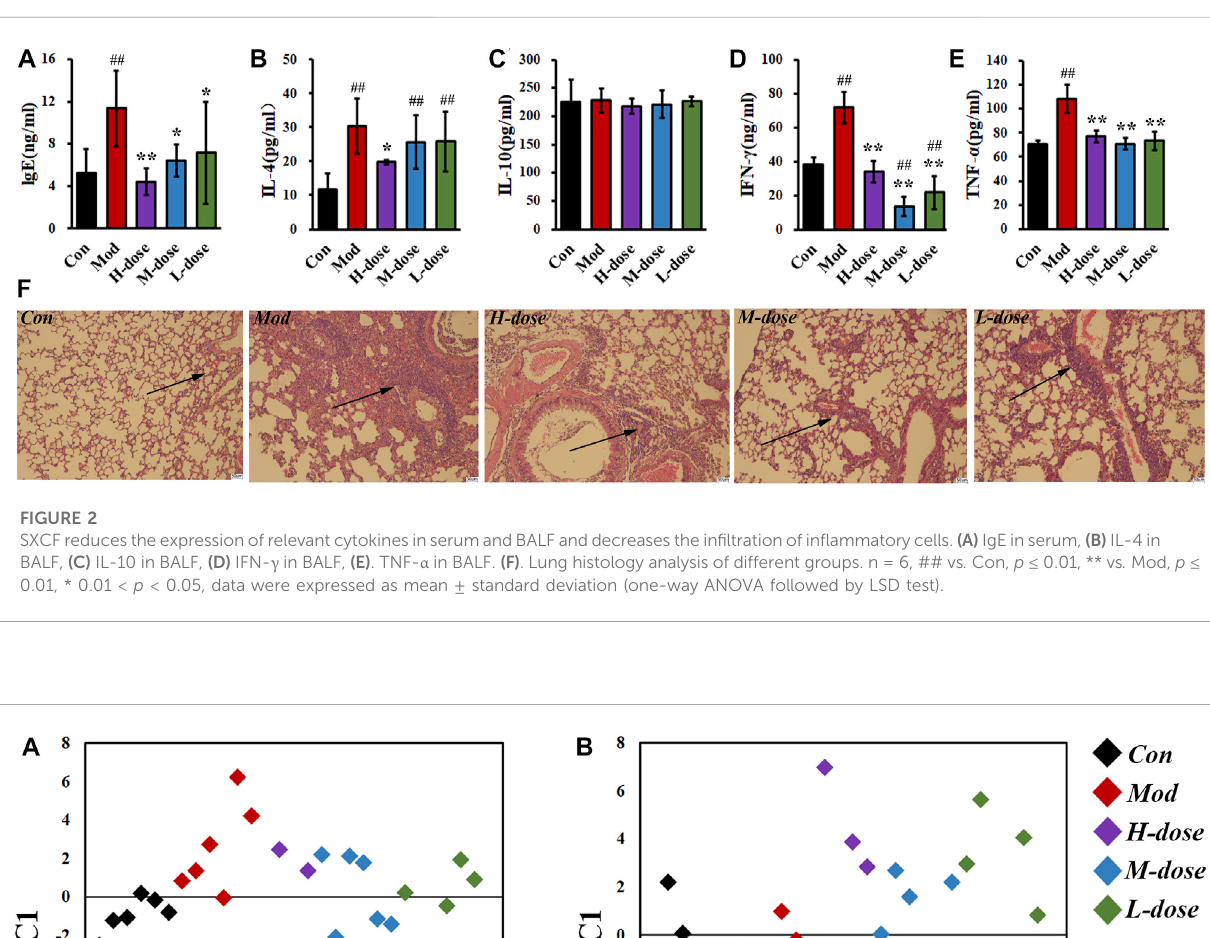
of the control group, indicating that OVA successfully induced asthma in mice. The scores of mice treated with SXCF were signi fi cantly lower than those of mice in the asthma group,